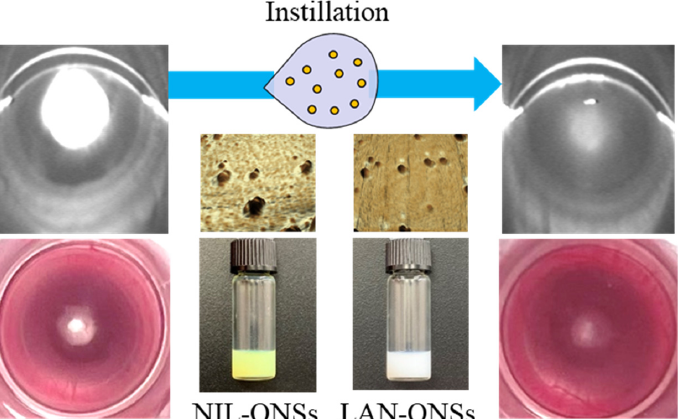
Figure 8. Scheme for recovery of lens opacification in sodium-selenite-induced cataractic rats through the repeated co-instillation of LAN-ONSs and NIL-ONSs.